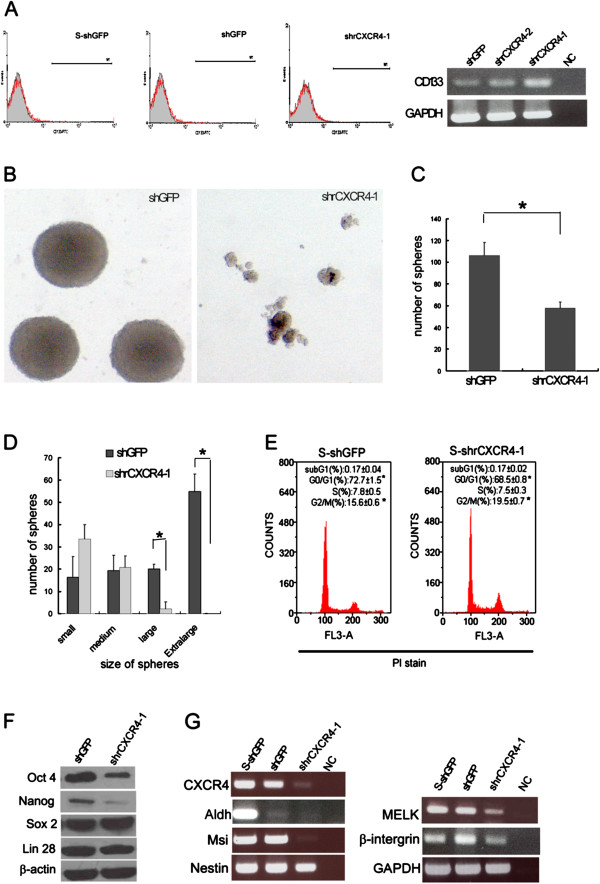
CXCR4 is required by glioblastoma cell lines for maintaining self-renewal characteristics of cancer stem-like cells. (A) Flow cytometry using anti-CD133 and RT-PCR indicated that RG2 had a low level of CD133. (B) Spheroid formation of the control shGFP and shrCXCR4 RG2 after culture in an ultralow dish for 10 d. Quantitative analysis showed a reduced number (C) and size (D) of spheres derived from the shrCXCR4 RG2 clone. Similar results were obtained from 2 independent experiments, and each experiment was performed in triplicate. (E) Histograms of cell cycle analysis showed that the deficiency of CXCR4 caused the reduction in G1 and the increase of G2/M populations. After being cultured in an ultralow dish 7d, the spheres derived from shGFP and shrCXCR4-1 were collected and trypsinized, and cell suspensions were subjected to PI staining. Comparing the cell cycle profiles revealed that the percentage of G2/M populations within cells collected from shrCXCR4-1 spheres (S-shrCXCR4, 19.5 ± 0.7%) was higher than those derived from shGFP (S-shGFP, 15.5 ± 0.6%) (*P < 0.05). By contrast, the percentage of G1 population within cells collected from shrCXCR4-1 (68 ± 0.8%) was lower than those from shGFP (72 ± 1.5%, *P < 0.05). (F) Western blot analysis showed that disrupting CXCR4 reduced the level of stem-cell-associated genes, including Oct4 and Nanog. (G) RT-PCR assay indicated that the expression of several genes, including stem-cell markers, Aldh, Nestin, Msi, and the proliferation promoting gene MELK increased in the control clone after forming spheroids, but decreased in the shrCXCR4-1 RG2. The shown were one of the similar results from 2 independent experiments.